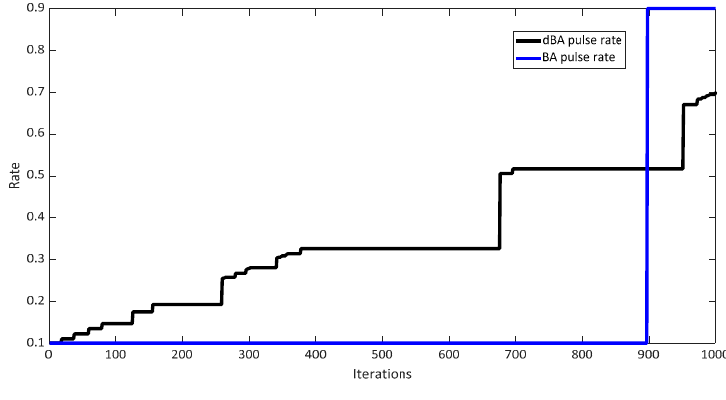
Figure 16. The pulse rate of the best bat of the BA and dBA. Energies 2020 , 13, x; FOR PEER REVIEW